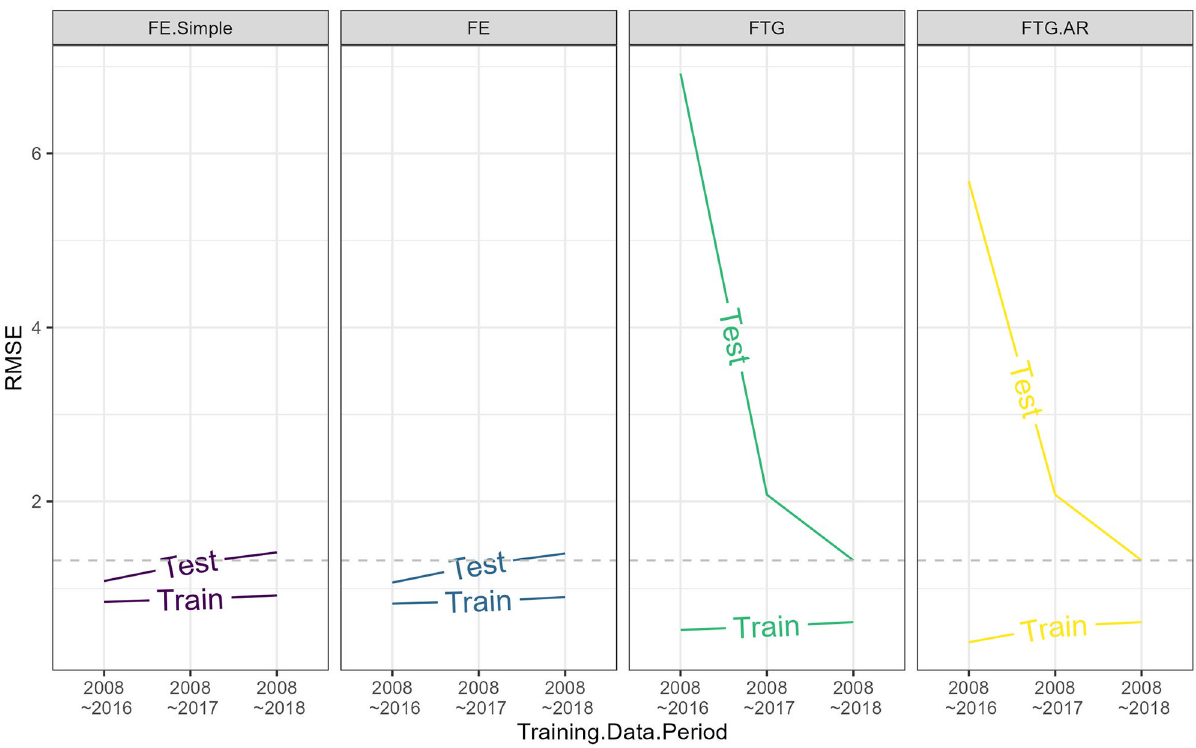
Fig 7. Effect of panel data length on model performance. Changes in training and testing errors (RMSE) with respect to the length of training data (as shown in Fig 4).